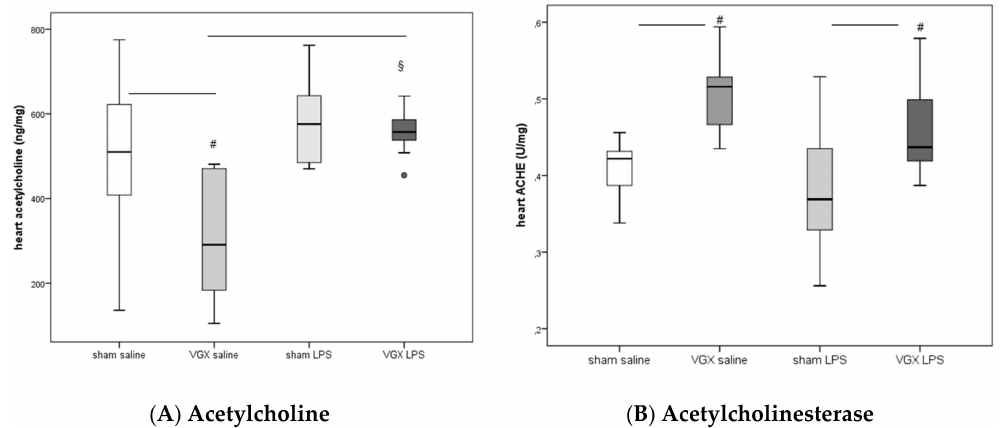
Figure 2. ( A ) Acetylcholine (ACH) and ( B ) acetylcholinesterase (ACHE) in rat heart at the end of the experiments. Data presented as median (IQR = Inter Quartile Range) at 4 h after LPS injection (T5). # : significant effect of right cardiac vagus nerve resection (ACH in ng/mg protein: p = 0.038, ACHE in U/mg protein: p = 0.004 (sham saline versus VGX saline) and p = 0.05 (sham LPS versus VGX LPS). § : significant LPS effect: (VGX saline versus VGX LPS, p = 0.016). The circles present